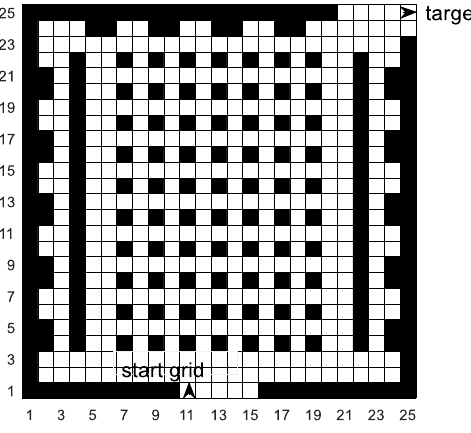
Figure 12. Simulation map environment.